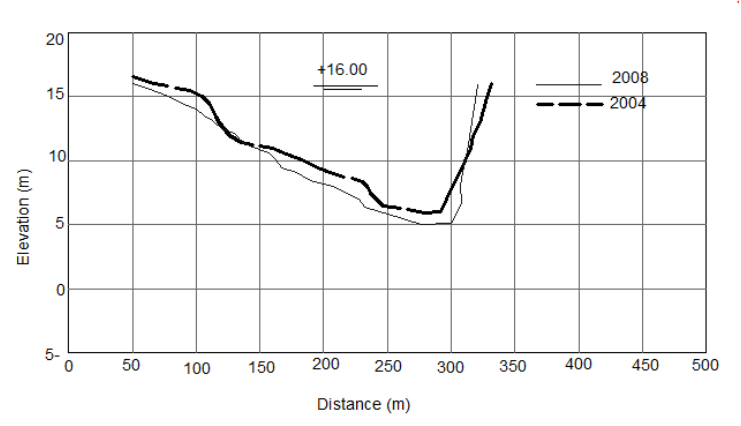
Figure 15. Cross section No.2 at years 2004 and